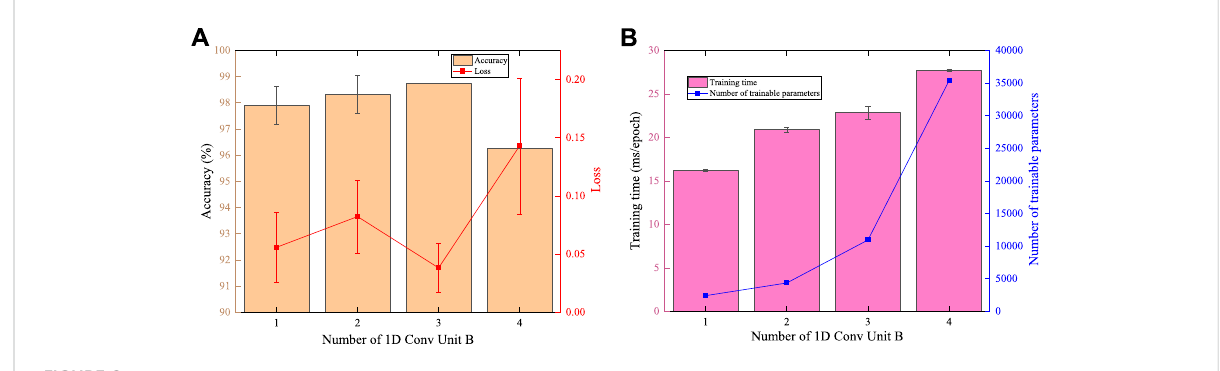
FIGURE 8 Results under different numbers of one-dimensional convolution units. (A) Accuracy and loss. (B) Training time and number of trainable parameters.